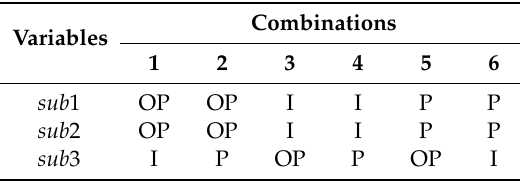
Table 2. Combinations of